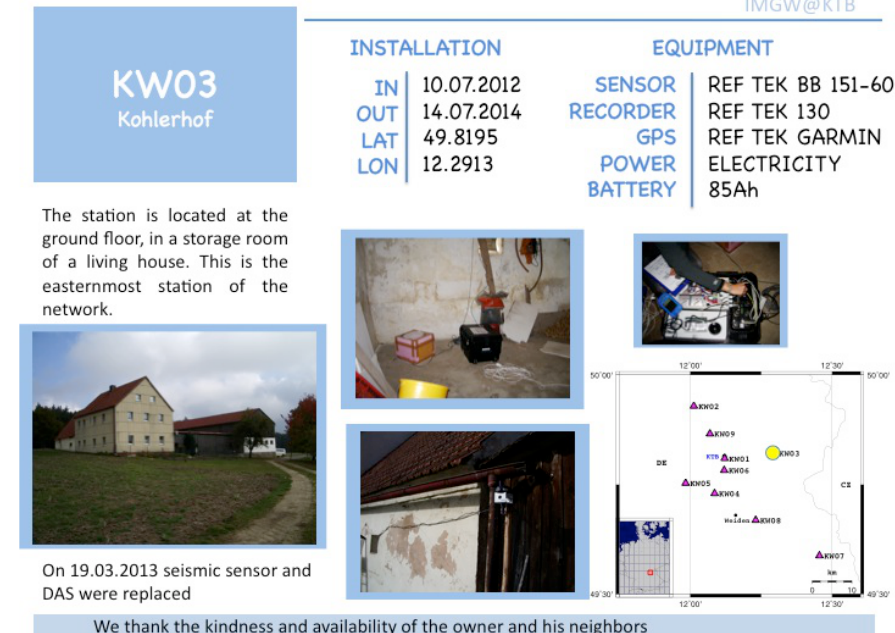
Figure A3. Station KW03 technical information.